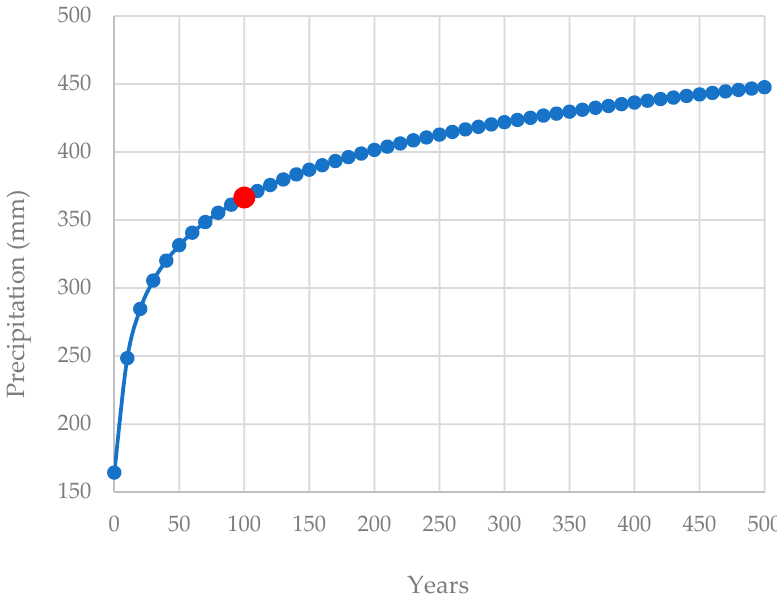
Figure A1. Ternary phase diagram.